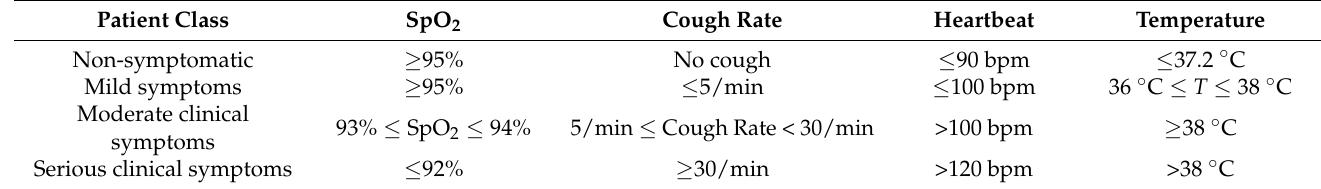
Table 2. COVID-19 symptom